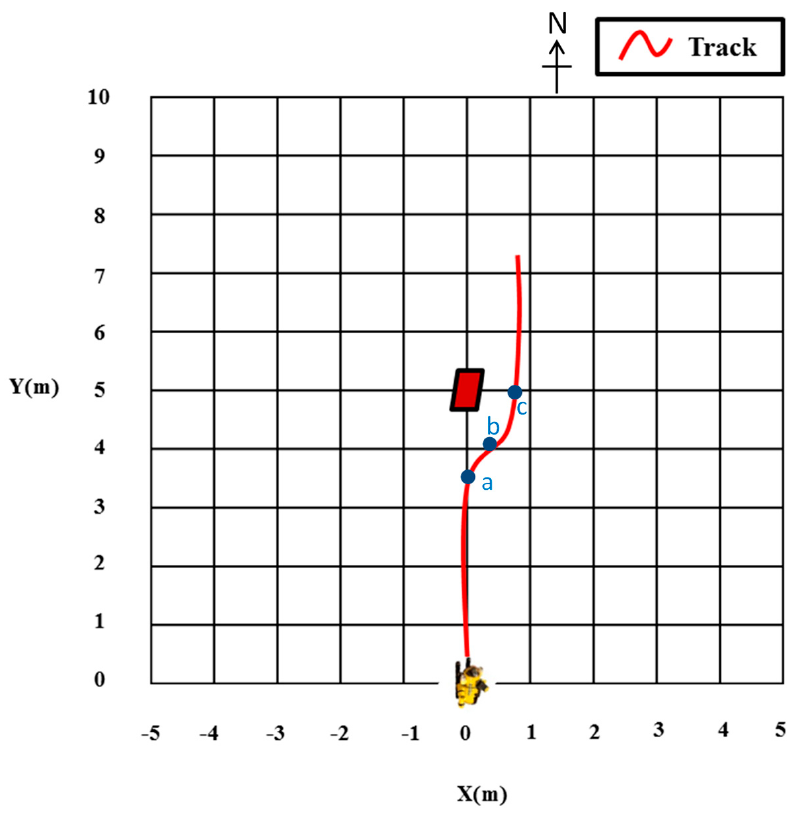
Figure 9. Simulated trajectory of the ROV’s obstacle avoidance. The points of the scan map are marked by blue lower-case letters. The red line signifies the trajectory of the ROV.